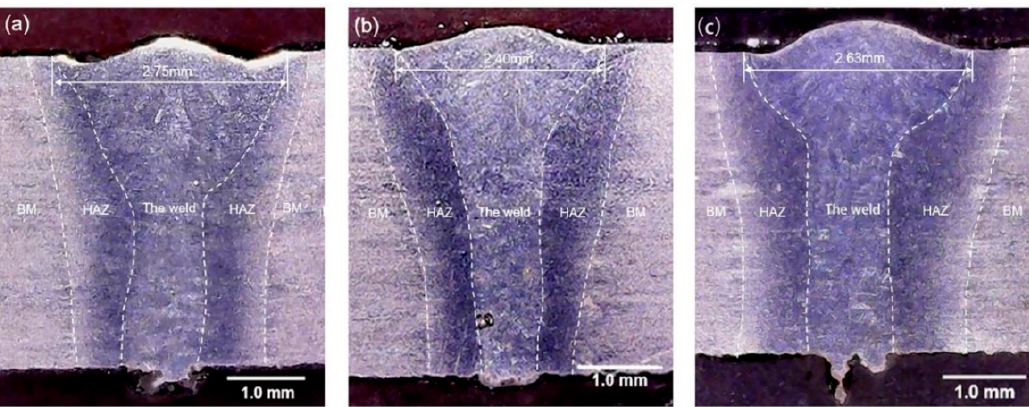
Figure 1. The cross-sectional morphologies of the weld joints ( a – c ): ( a ) sample I; ( b ) sample II; ( c ) sample III.